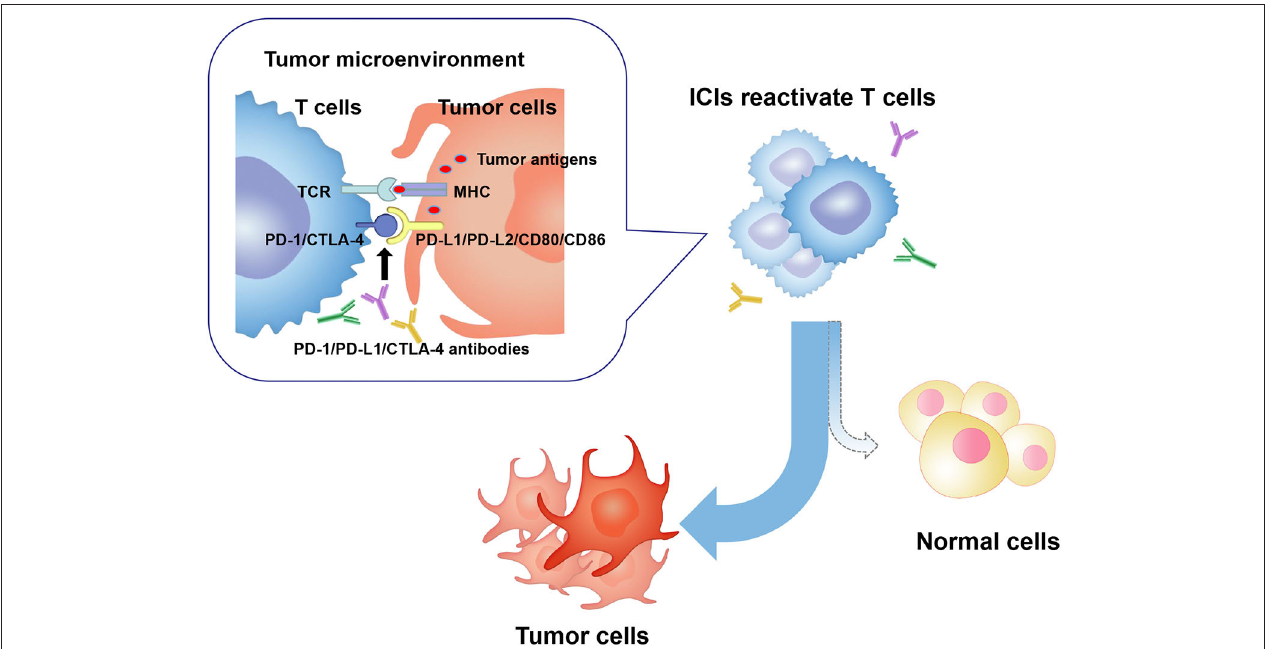
FIGURE 1 | In the tumor microenvironment, PD-1/CTLA-4 molecules on activated T cells are up-regulated and combined to PD-L1/PD-L2 or CD80/CD86 molecules on tumor cells. Consequently, T cell activity is inhibited, and an immunosuppressive microenvironment is formed, which leads to tumor cells escaping the immune surveillance and growing wildly. ICIs restore anti-tumor activity of T cells by targeting and blocking PD-1 or CTLA-4 signaling pathway. Activated T cells kill tumor cells and may attack normal human tissue cells, forming ICIs-related toxicities. PD-1, programmed cell death protein 1; PD-L1/2, programmed cell death ligand 1/2; CTLA-4, cytotoxic T lymphocyte-associated antigen-4; ICIs, immune checkpoint inhibitors; MHC, major histocompatibility complex; TCR, T cell